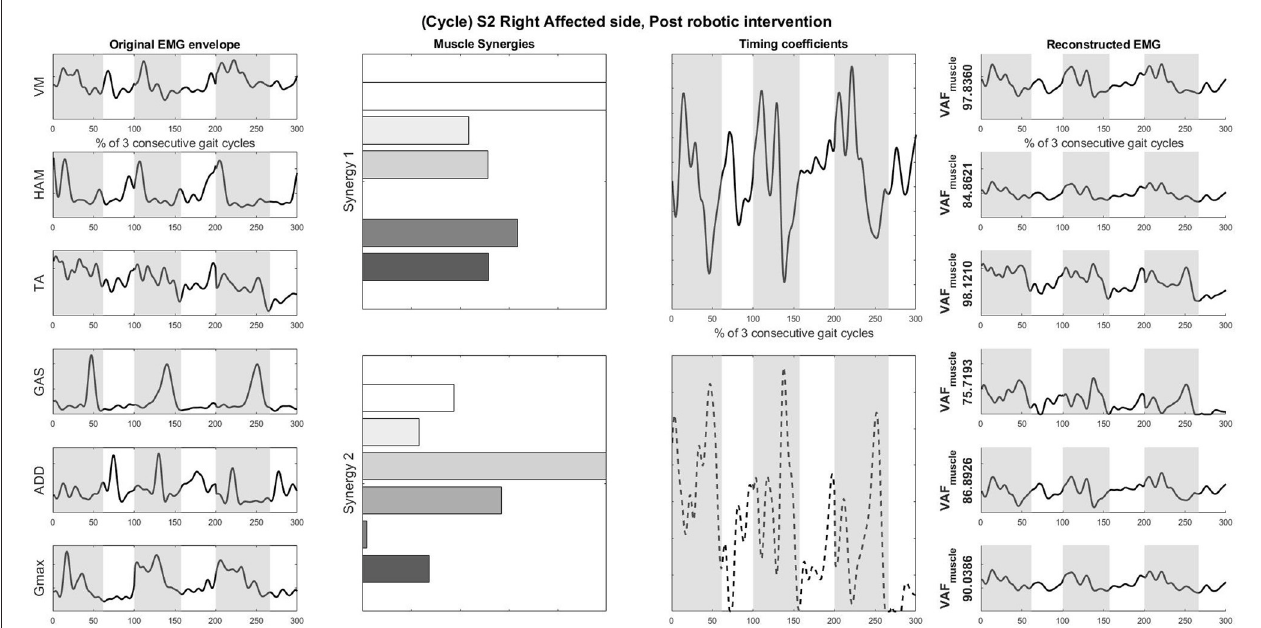
FIGURE 5 | Original EMG envelope, muscle synergies, timing coefficients and Reconstructed EMGs for affected side, post HAL intervention, computed by NNMF with 2 synergies. Each bar of the synergy set is matched with the order of muscles in the “Original EMG” (Left) column, namely (from top bar to bottom bar) VM, HAM, TA, GAS, ADD, Gmax. Similarly, each plot in the “Individual Reconstructed EMG” column is matched with the order of the muscles in the “Original EMG” (Left) column. Each line pattern represents the reconstructed EMG from each motor module. Shaded areas denote stance phases.